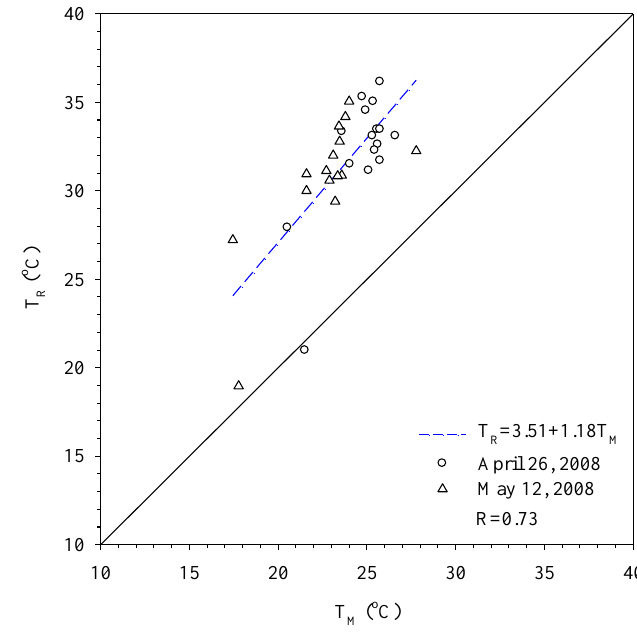
Figure 4. Comparison of temperatures measured by meteorological stations ( T estimated by remote sensing ( T